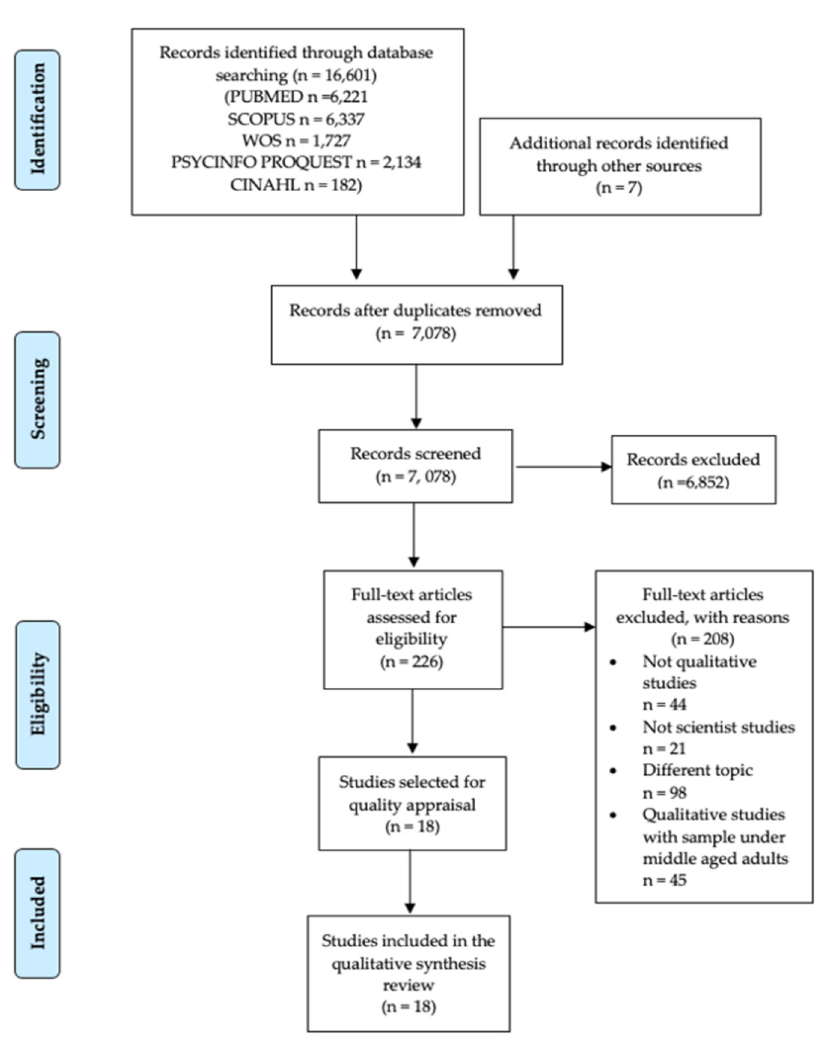
Figure 1. Preferred Reporting Items for Systematic Reviews and Meta-Analysis (PRISMA) flow chart. 198